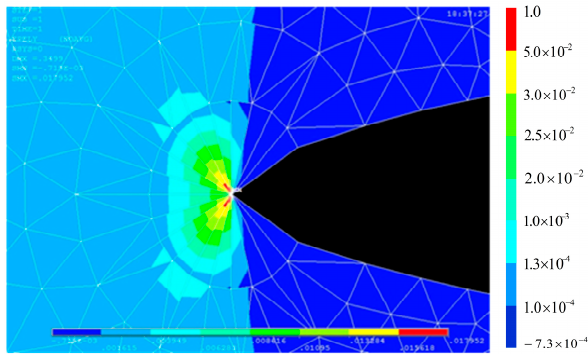
Figure 5. Meshes around the crack.